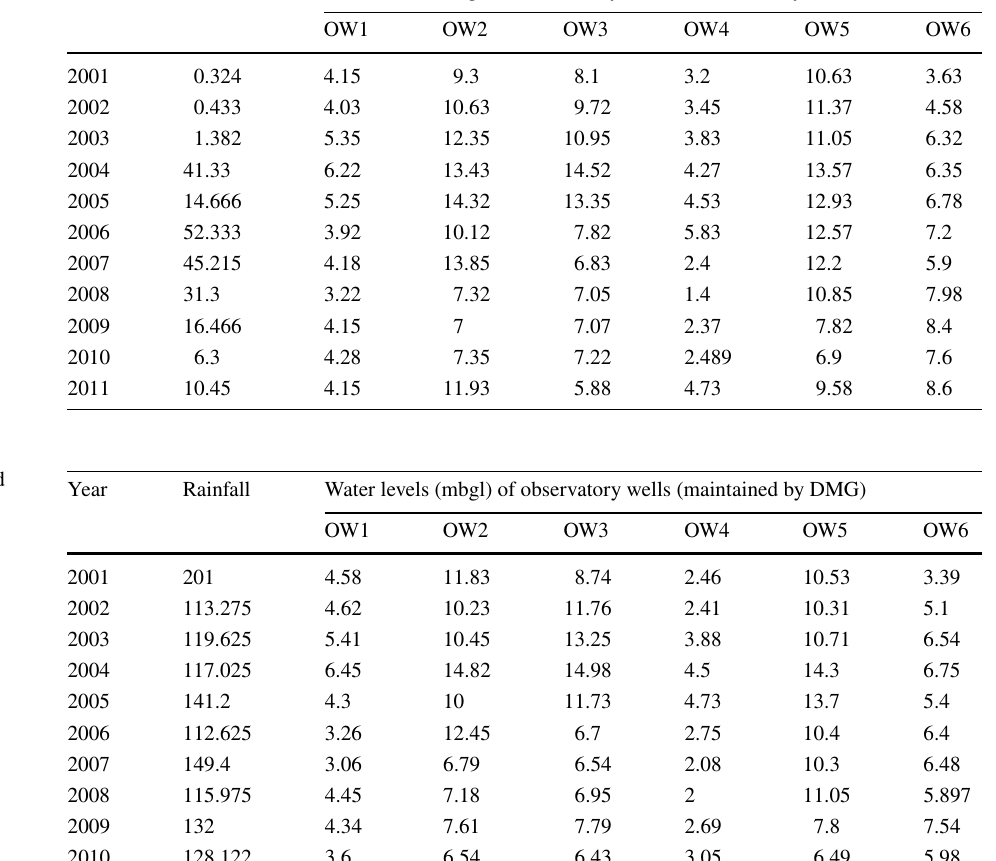
Table 5 Summer rainfall and water-table records